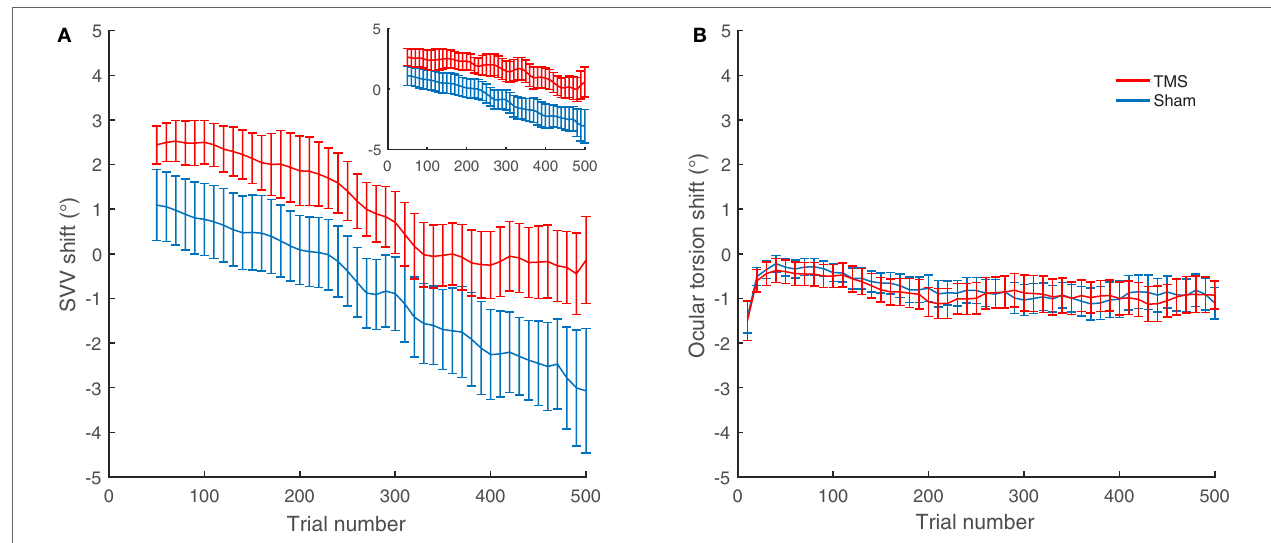
FigUre 4 | SVV and ocular torsion shifts following TMS and sham stimulation in all participants: (a) The average SVV shift from TMS at the supramarginal gyrus (SMGp) (red) is in the opposite direction of the head tilt and larger compared to the average SVV shift from the sham stimulation (blue). The small inset shows the similar result from the first TMS session at SMGp. (B) The average ocular torsion shift from TMS at SMGp (red) is not significantly different from the average ocular torsion shift from the sham stimulation (blue). Error bars represent SEM.